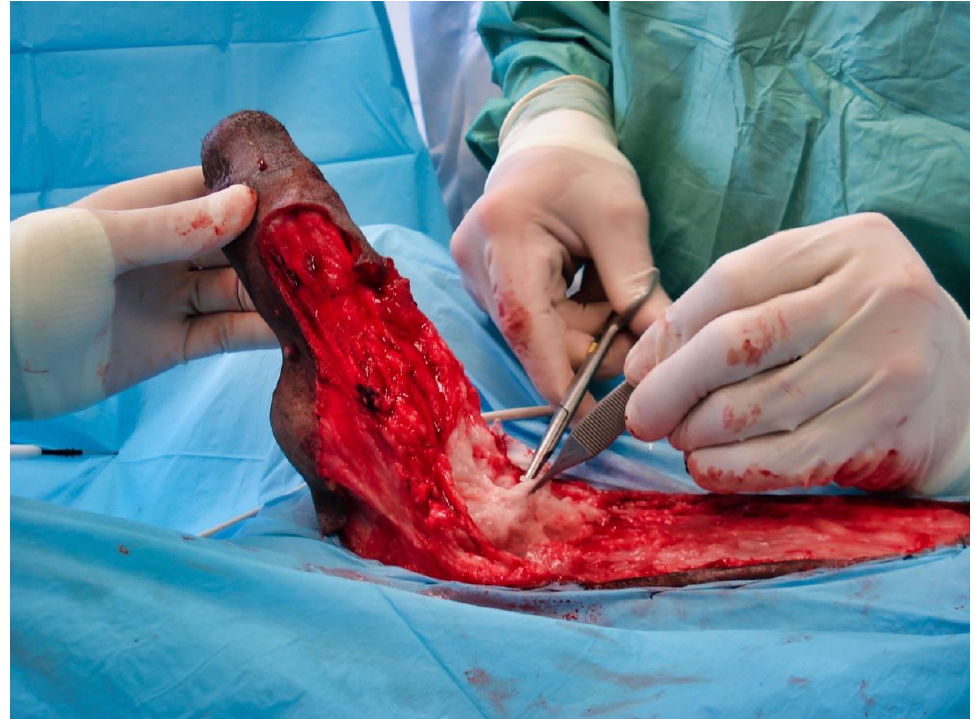
Figure 5. Intraoperative view of the amputation of the penis.